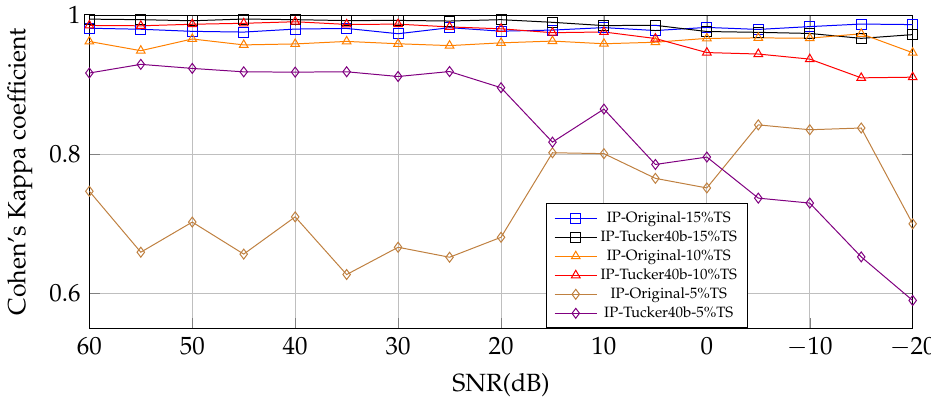
Figure 14. Indian Pines. Cohen’s Kappa coefficient obtained using 3DCNN DL model trained for 40 epochs from the original IP HSI and compressed with TKD to 40 tensorial bands. From 60 to − 5 dB, Tucker improved the performance for Cohen’s Kappa coefficient.